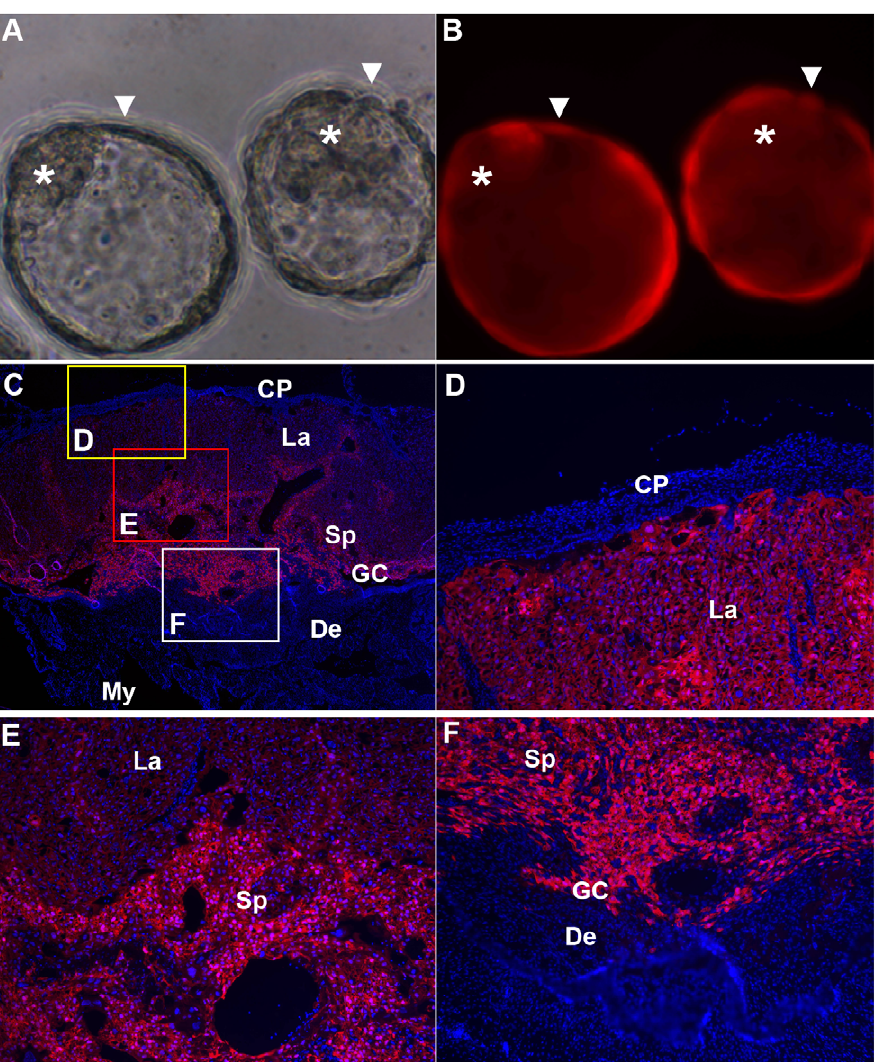
Figure 3. Trophoblast-specific Tomato expression by lentivirus-mediated transgene delivery into blastocysts. Tomato expression was examined in zona-free blastocysts infected with LV-Fluc/Tomato (A–B) and in GD18 placentas (C–F) after blastocyst transfer into pseudopregnant mice. A–B, phase-contrast (A) and fluorescence (B) images showing Tomato expression in the trophectoderm of blastocysts (A, B, . ) and not in the inner cell mass (A, B, *). C–F, Tomato expression in trophoblast lineages of placentas; D–F, magnified areas in C; giant cells (GC), spongiotrophoblast (Sp) and labyrinth (La) layers, decidua (De), myometrium (My), and chorionic plate (CP).